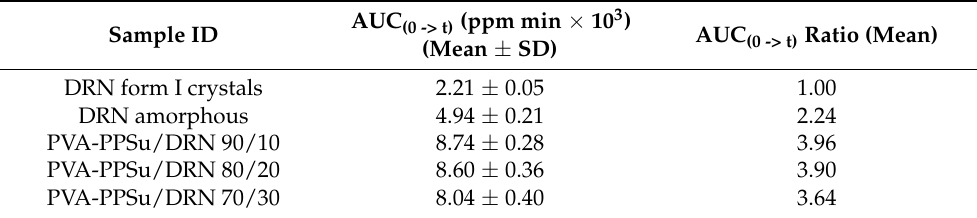
Table 3. Summary in vitro dissolution estimated AUC (0 -> t) for the amorphous DRN and the ASDs, along with the estimated mean AUC (0 -> t) ratio (i.e., AUC (0 -> t) (sample)/AUC (0 -> t) (DRN form